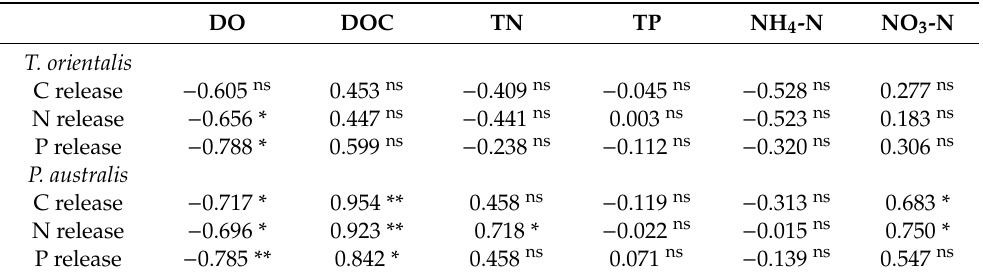
Table 2. Pearson’s correlation coefficients between the concentrations of DO, DOC, TN, TP, NH 4 -N, and NO 3 -N in the water column and the release rates of C, N, and P from plant materials.